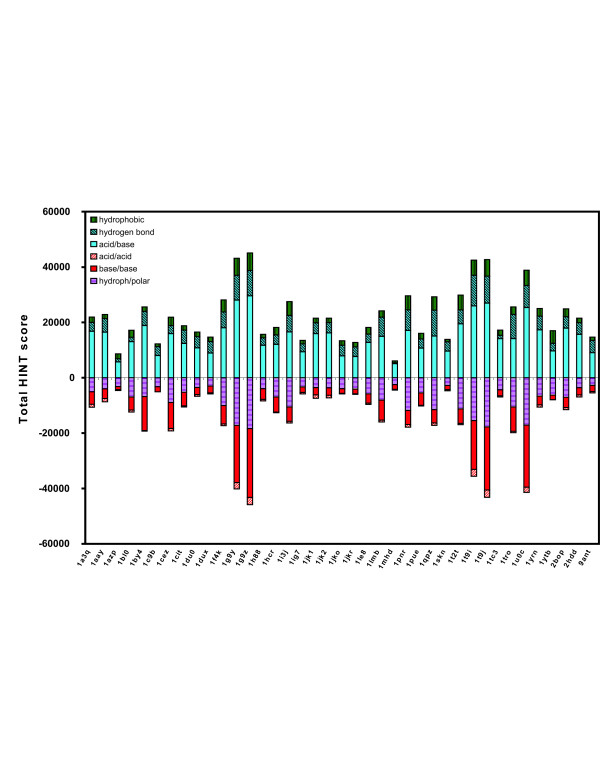
Contributions of the different interaction types participating in the direct protein-DNA association process, as estimated by the HINT force field. The bars are color-coded as indicated in the legend.